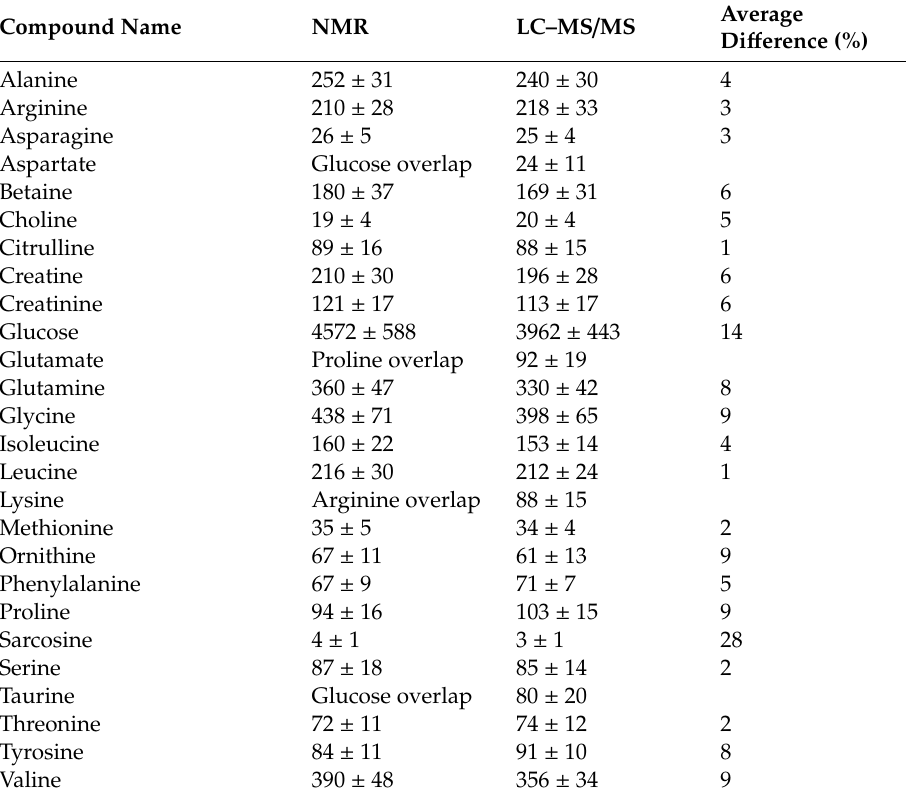
Table 3. Comparison of concentrations of 26 metabolites between nuclear magnetic resonance (NMR) and liquid chromatography–tandem mass spectrometry (LC–MS / MS) methods along with their measured or reported concentrations and their standard deviations and / or ranges in bovine serum (as measured in µ